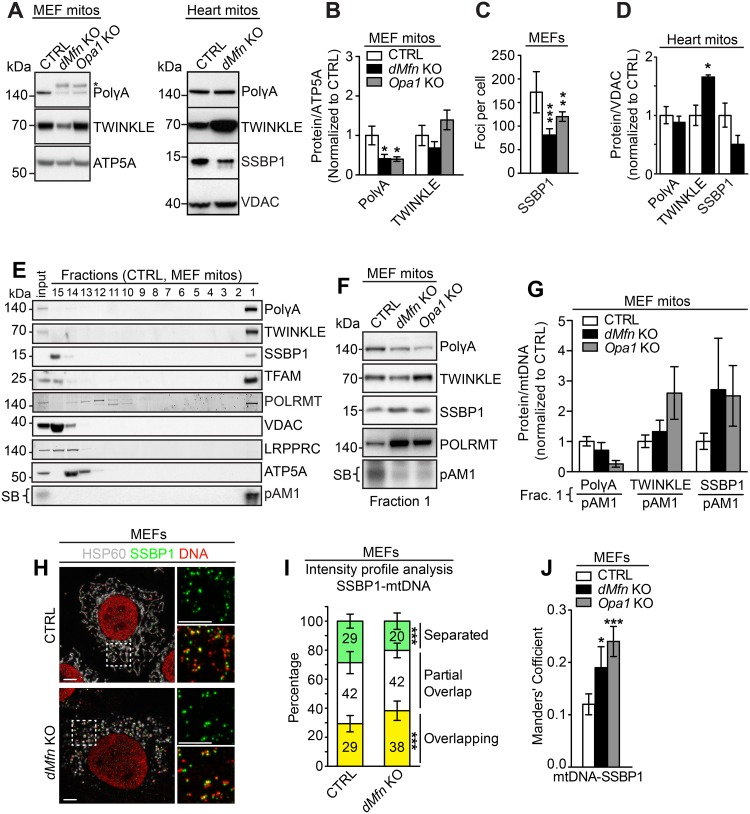
Loss of mitochondrial fusion affects replisome composition.(A) Left, representative western blot showing the steady-state levels of mitochondrial replication proteins from isolated MEF mitochondria from control, dMfn KO, Opa1 KO MEFs. Right, representative western blot showing the steady-state levels of mitochondrial replication proteins in isolated heart mitochondria from control and dMfn KO mice at 5–6 weeks of age. (B) Quantification of the steady-state levels of replisome proteins as determined by western blot analysis of mitochondria from control, dMfn KO, and Opa1 KO MEFs. Replisome protein levels were normalized to ATP5A (n = 7 per genotype). (C) Quantification of SSBP1 foci per cell in control, dMfn KO, and Opa1 KO MEFs. Cells were immunostained with anti-SSBP1 and anti-HSP60 antibodies, n = 4 for each genotype, 5–8 cells analyzed per n. (D) Quantification of mitochondrial replication proteins levels in isolated heart mitochondria from control (n = 3) and dMfn KO (n = 3) mice at 5–6 weeks of age, normalized to VDAC. (E) Representative western blot analysis of glycerol gradient fractions from mitochondria isolated from control MEFs. Upper panel corresponds to western blotting and lower panel shows Southern blot (SB) analysis to detect mtDNA by using the pAM1 probe. (F) Representative western blot analysis of fraction 1 from the glycerol density gradient. In total, 4 independent biological samples were used for all genotypes. (G) Quantification of the western blot analysis of fraction 1 from the glycerol density gradient related to (F), n = 4 for all genotypes. (H) Representative confocal image of control and dMfn KO MEFs immunostained with anti-SSBP1 and anti-dsDNA antibodies, n = 3 for each genotype. Scale bars represent 5 μm. (I) Line scan analysis based on intensity profiles of SSBP1 and mtDNA of control and dMfn KO MEFs, n = 3 for each genotype, 7–10 cells analyzed per n. Line scans generated intensity profiles that were separated into three categories, no overlap of intensities between SSBP1-mtDNA (free SSBP1), partial overlap between SSBP1-mtDNA intensities, and complete overlap of intensities between SSBP1-mtDNA. (J) Mander’s Coefficient, related to H, expressing the degree of mtDNA foci colocalizing with SSBP1 foci from confocal acquired images in control (n = 4 independent experiments, 23 cells analyzed per n) and dMfn KO (n = 3 independent experiments, 16 cells analyzed per n), Opa1 KO MEFs (n = 3 independent experiments, 22 cells analyzed per n). For all, error bars indicate ± SEM. (For D and I) Student T-test; *, P < 0.05; **, P < 0.01; ***, P < 0.001. For (B, C, G, and J), one-way ANOVA using Turkey’s multiple comparison test relative to control; *, P < 0.05; **, P < 0.01; ***, P < 0.001.